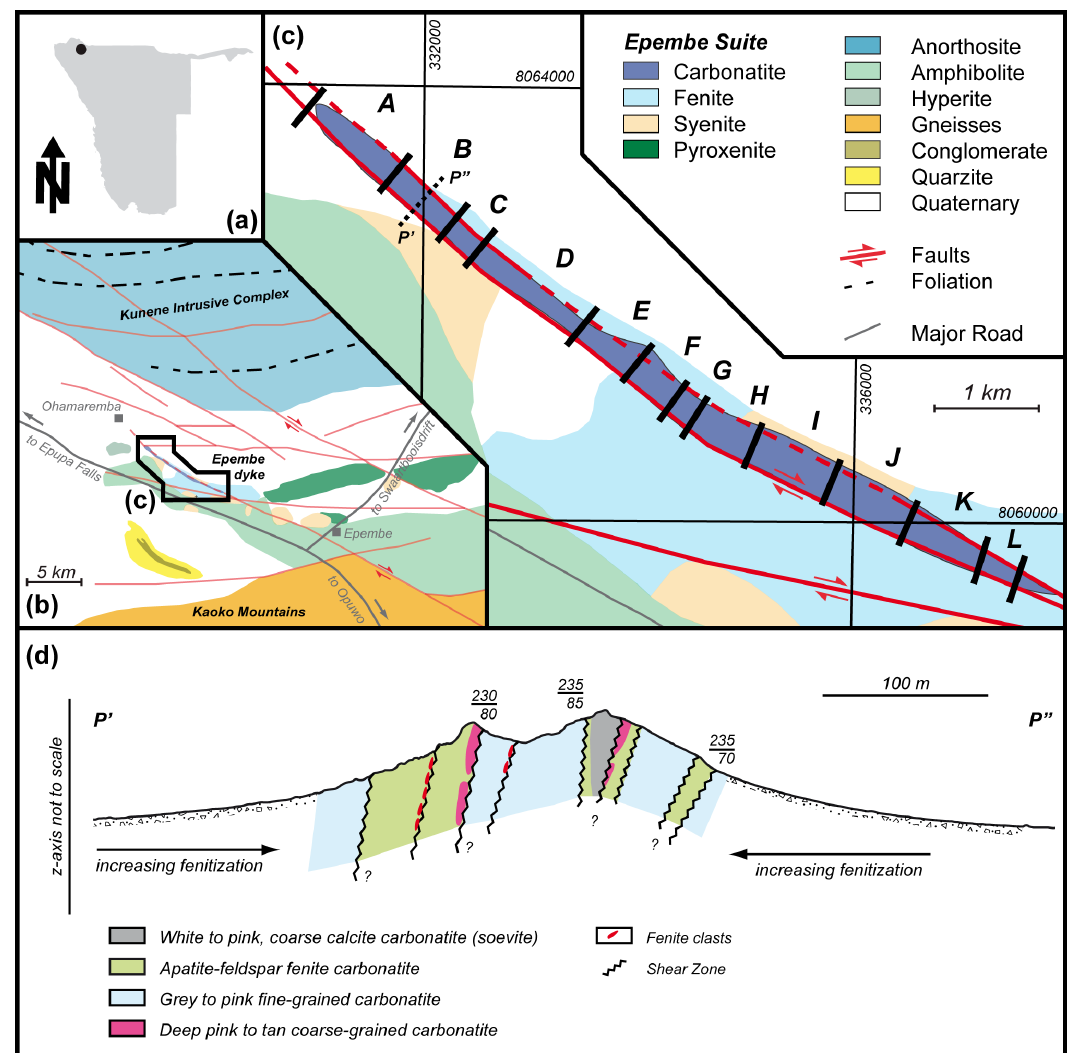
Figure 1. ( a ) Location of the Epembe dyke in Namibia. ( b ) Geological map of the Epembe region (after Zimmermann et al. [27] and the references therein) with ( c ) a detailed geological map of the Epembe dyke. Superimposed are the 12 artificial sectors as divided by Kunene Resources (pty) Ltd., Klein-Windhoek, Namibia. ( d ) Schematic cross-section P’–P” (sketch not to scale; dashed line in ( c )) perpendicular to the dyke in Sector B as interpreted from field